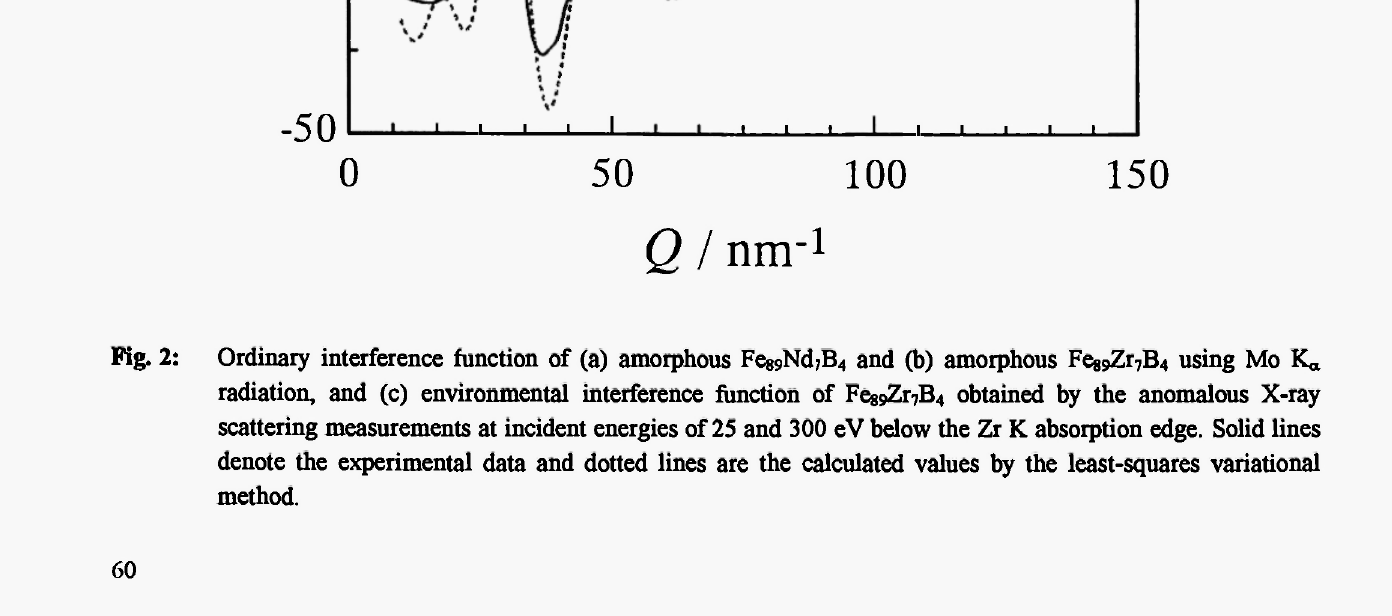
B using Mo K„ 7 4 B obtained by the anomalous X-ray 7 4